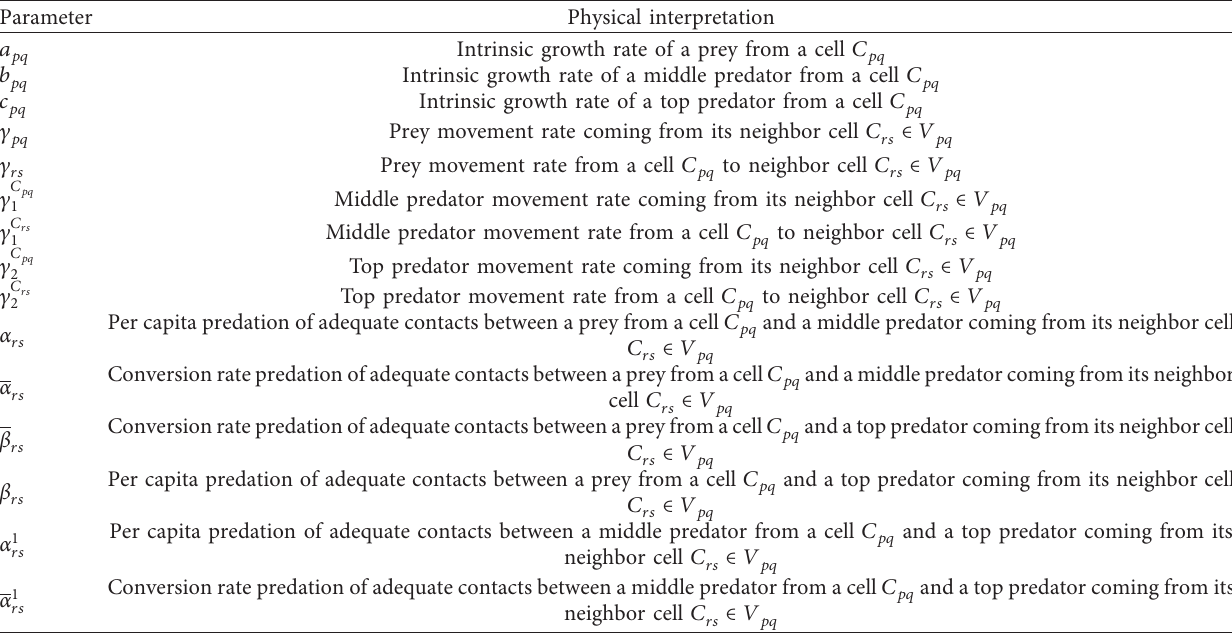
Table 2: List of all parameters of system